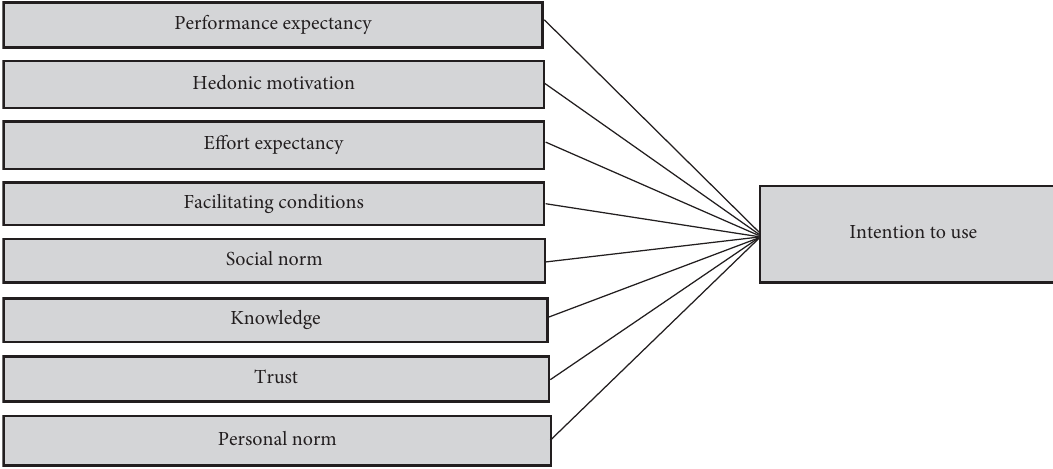
Figure 2: Research model for the online